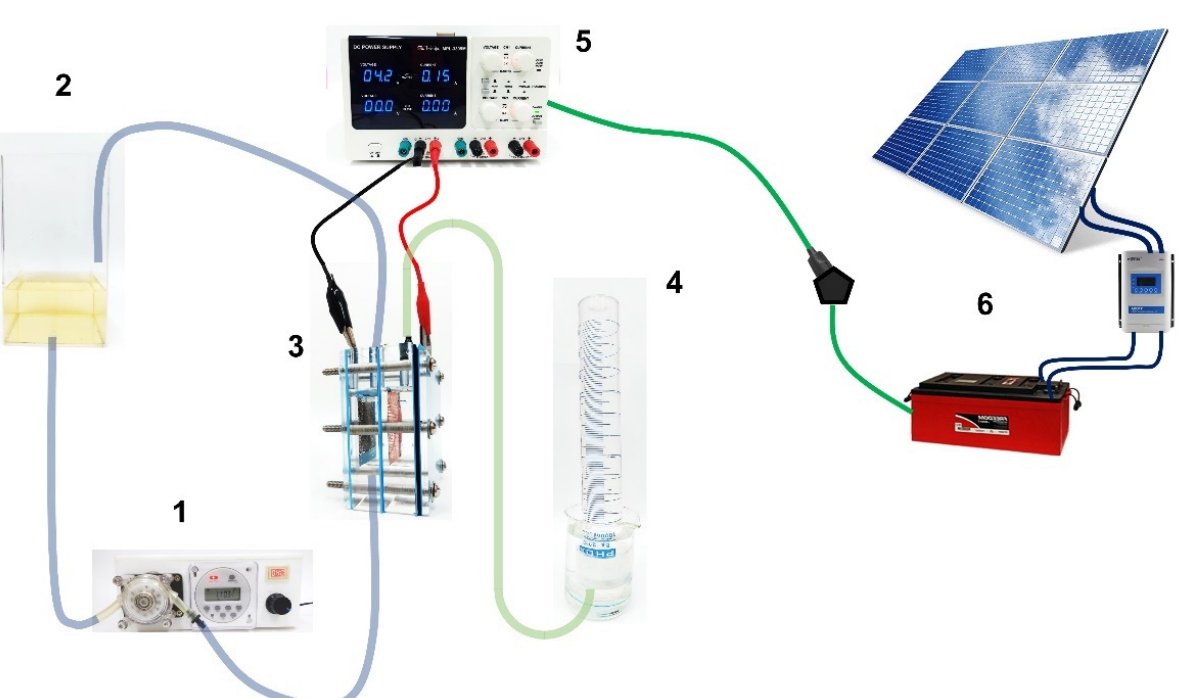
Figure 1. Diagram of the complete electrochemical system, including the photovoltaic power module: (1) peristaltic pump, (2) Calcon dye solution reservoir (1 L), (3) electrochemical cell PEM-type, (4) H 2 collector, (5) power supply, (6) solar photovoltaic (PV)-battery system.